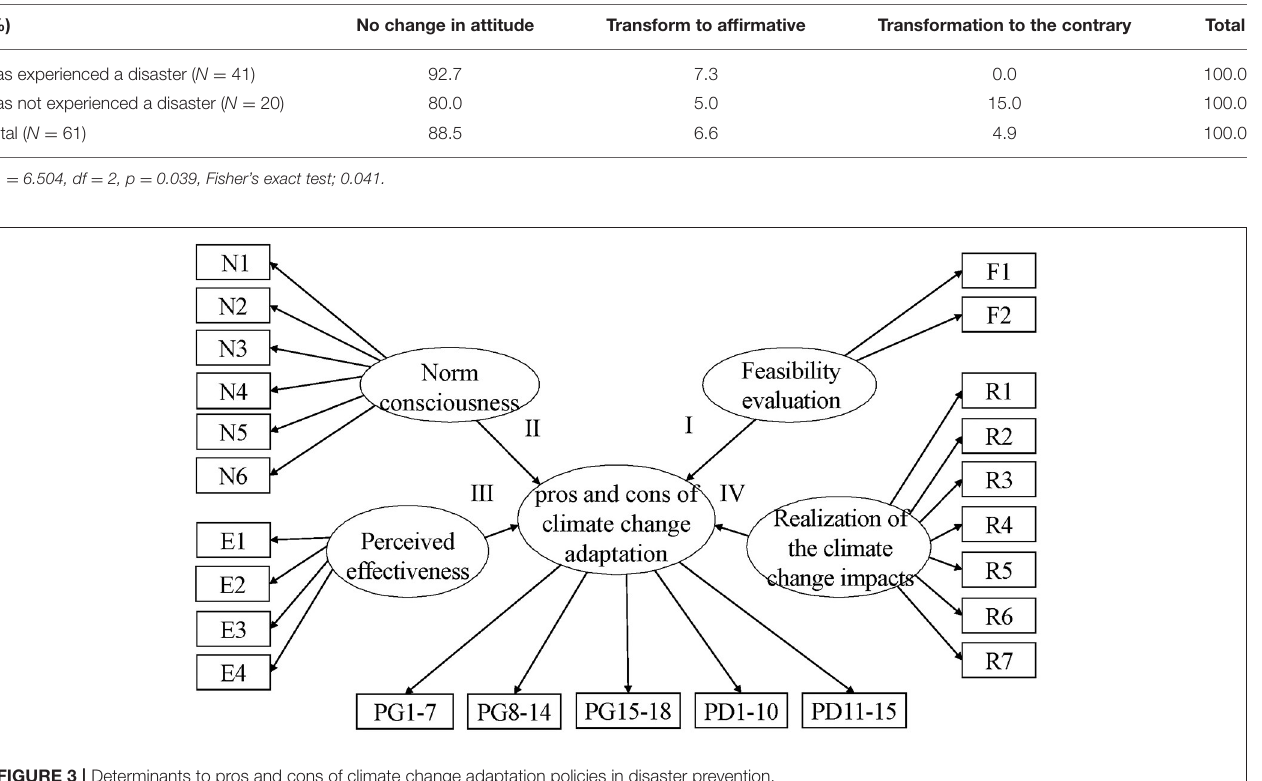
( Table 10 ). First, when participants were asked to rate the conditions of deliberation on a scale of 1 to 5 (with 1 signifying “do not agree at all” and 5 signifying “very much agree”), the score for the item “discussions centered around several people who spoke frequently” was the highest, followed by the item “lively discussions were held between my fellow participants,” indicating a split regarding the state of member participation in the actual